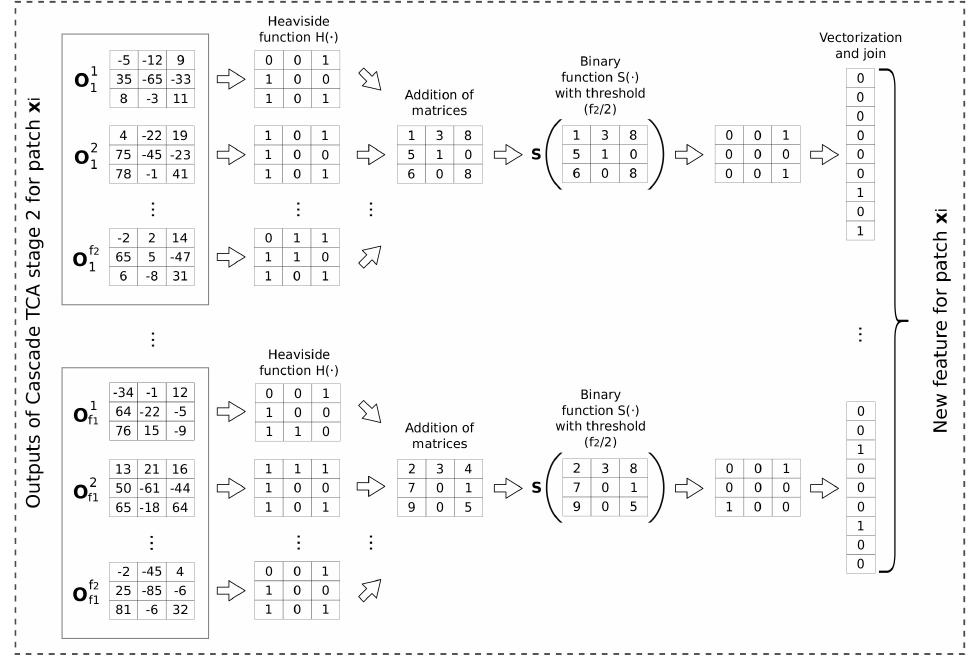
Figure 7. Example of feature extraction scheme considering input patches of 3 × 3 pixels.